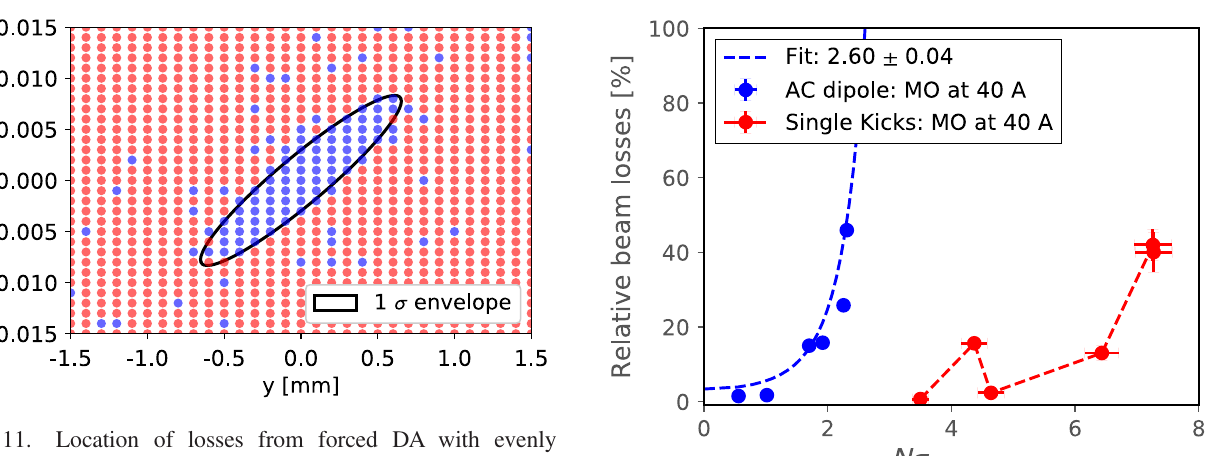
FIG. 11. Location of losses from forced DA with evenly sampled vertical phase space. In black the phase space ellipse at 1 σ is drawn for reference.